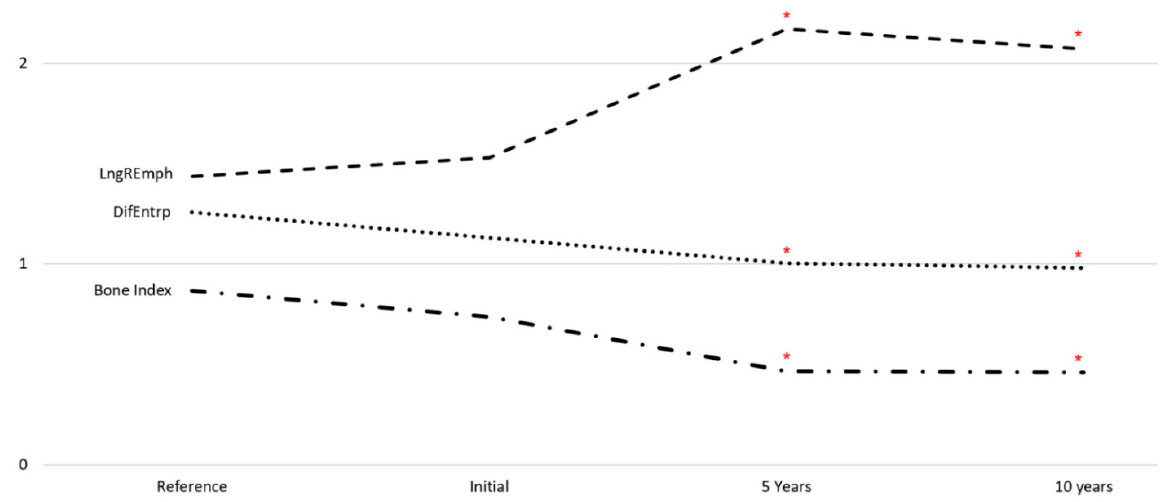
Figure 3. Texture characteristics studied over 10 years (medians). At the time of exposure of the dental implants, all features studied were identical to those of the trabecular reference bone. After five and ten years of functional loading, both studied features of the bone radiograph as well the bone index were statistically significantly different from the reference bone (and from the bone texture at the time of uncovering as well). Red asterisks indicate statistically significant differences from the reference bone; LngREmph—long run-length emphasis moment; DifEntrp—differential entropy. Table 2. Pooled data describing the progressive increase in the difference in bone structure of implant- loaded versus reference trabecular bone (bone index) and the observed associated, marginal bone loss